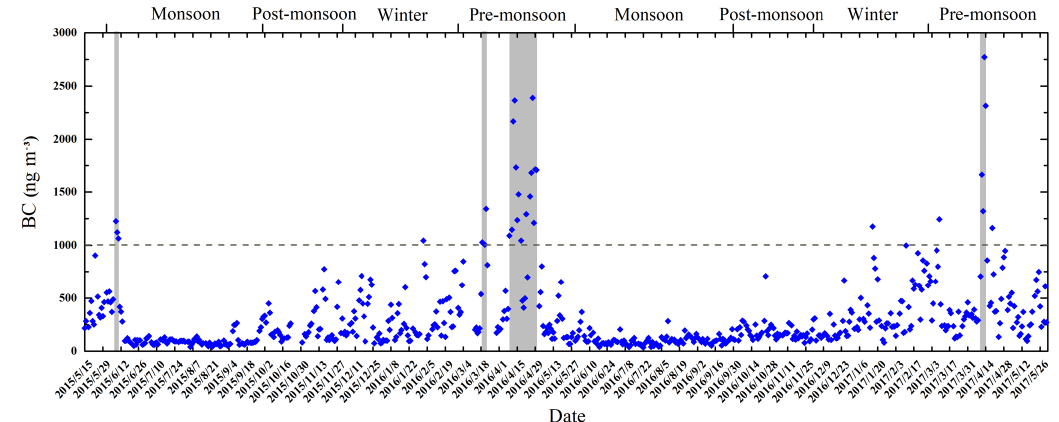
Figure 3. Daily mean BC concentrations at QOMS during study period (the gray bars represent the continuously high values more than 1000ngm − 3